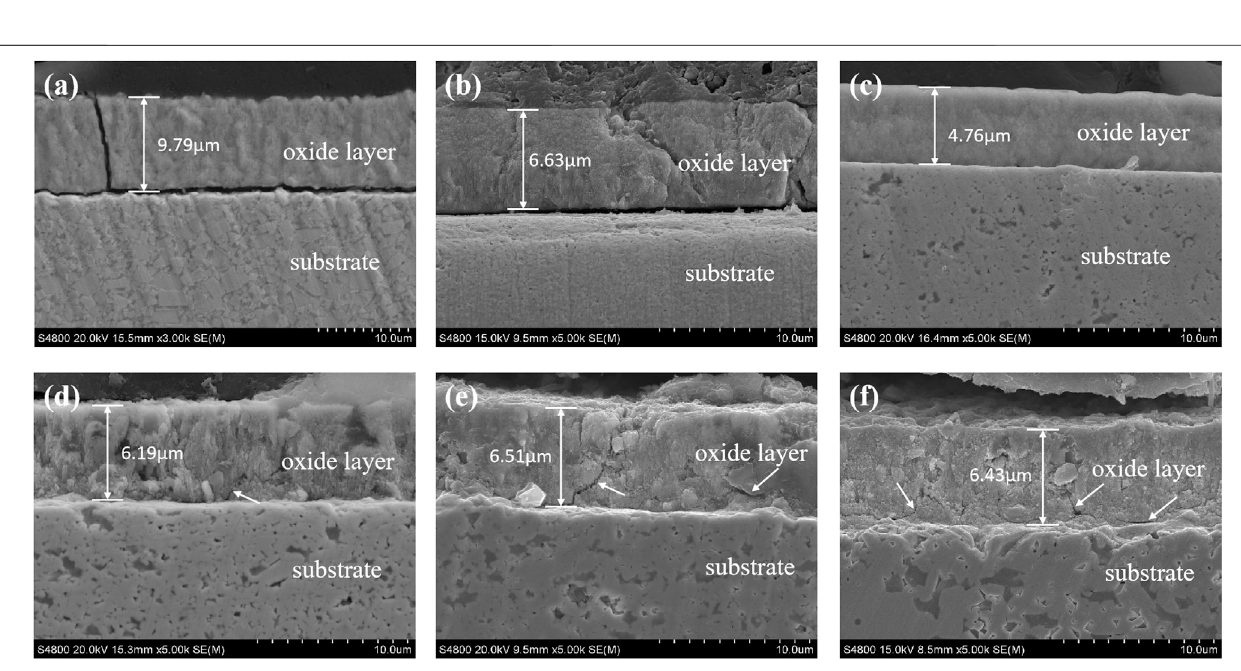
FIGURE6| Cross-sectionmorphologyofthedifferentWCcementedcarbidesoxidizedat873 Kfor30 min. (A) YG3; (B) pureWC; (C) WC-1wt.%Y 2 O 3 ; (D) WC-2 wt.% Y 2 O 3 ; (E) WC-3 wt.% Y 2 O 3 ; (F) WC-4 wt.% Y 2 O 3